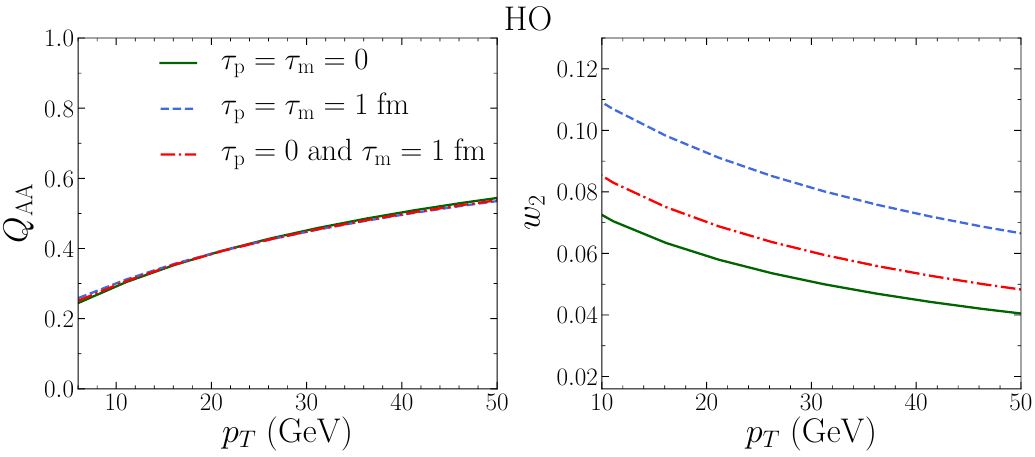
Figure 8 . Our proxies for the R AA (left panel) and high- p T v 2 (right panel) for the 20 - 30% √ centrality class in s NN = 2 . 76 TeV Pb-Pb collisions at the LHC as function of p T obtained within the HO approximation for the three scenarios analyzed in this paper: τ p = τ m = 0 fm (green solid lines), τ p = τ m = 1 fm (blue dashed lines); and τ p = 0 fm and τ m = 1 fm (red dash-dotted